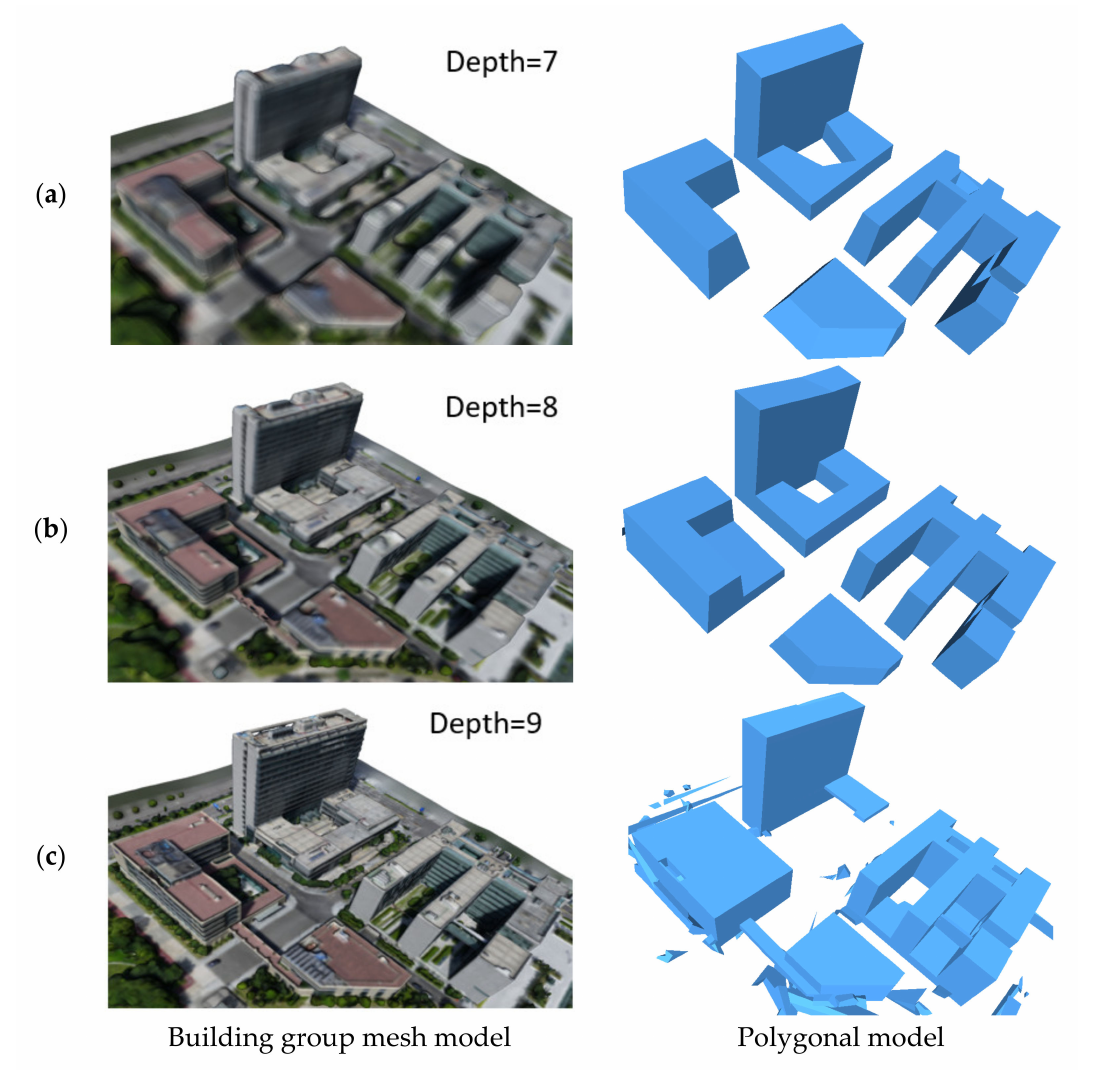
Figure 19. Multi-building scene reconstruction results. ( a ) depth = 7, ( b ) depth = 8 and, ( c ) depth = 9.